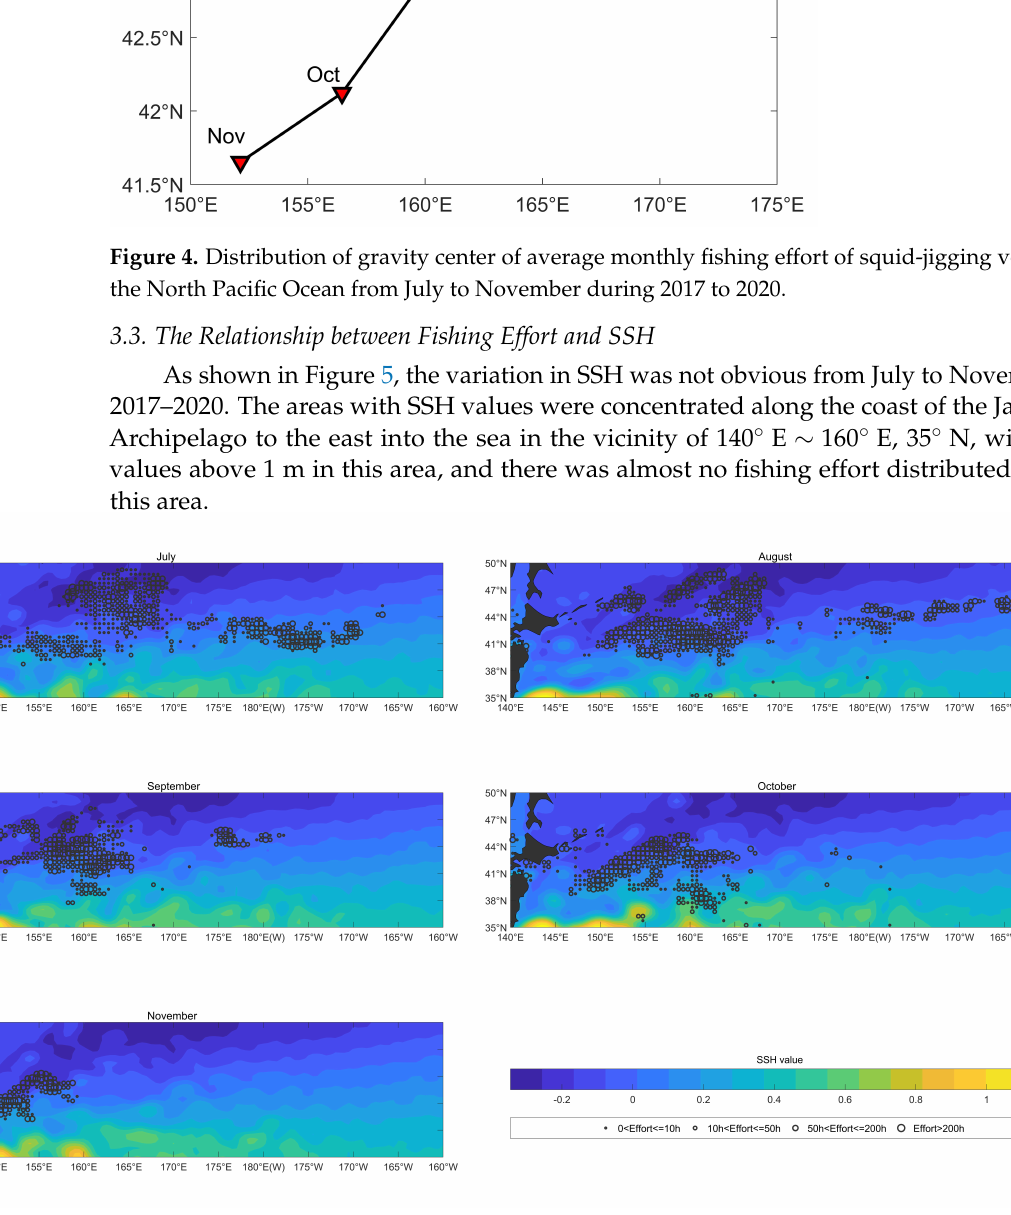
Figure 5. The overlay map of SSH (color shading; units: m) and monthly fishing efforts (circle; units: h) of O. bartramii in the North Pacific Ocean from July to November from 2017 to